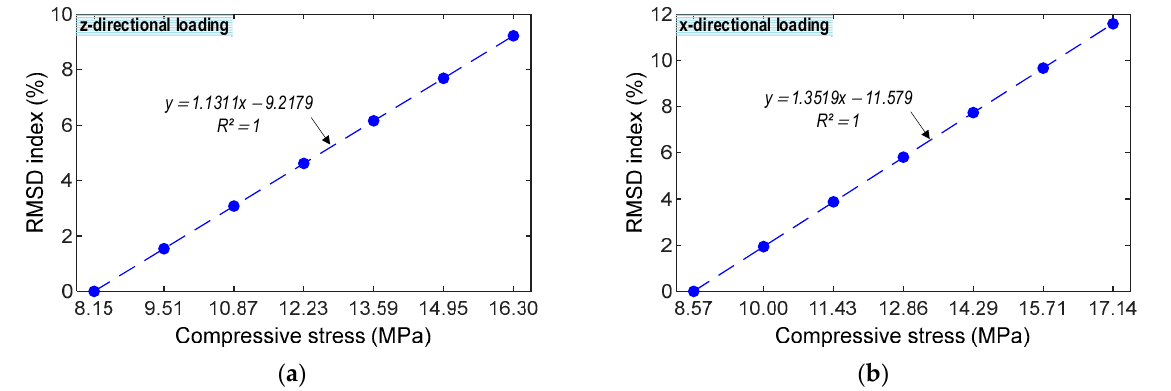
Figure 10. Numerical correlation estimation between RMSD index and compressive stress. ( a ) z- directional loading. ( b ) x-directional loading.